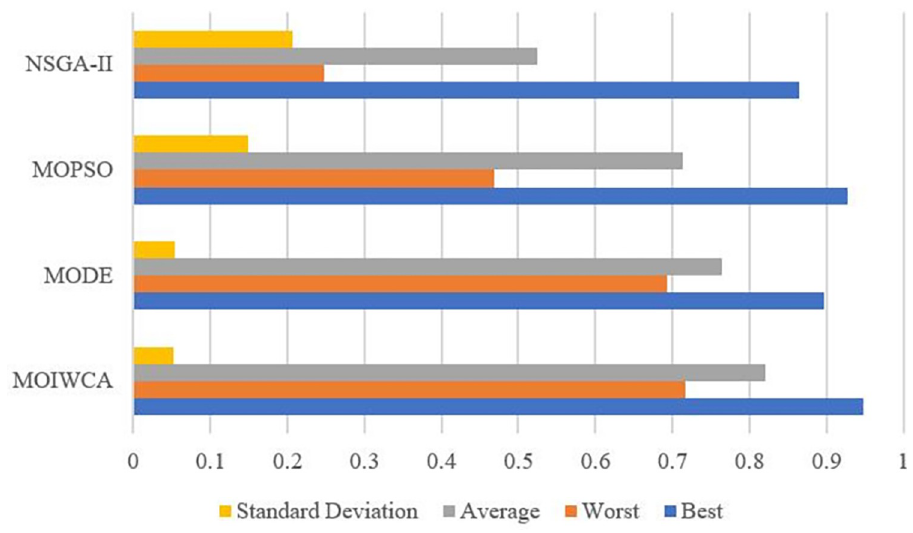
Fig 17. Comparison of HV metric for different